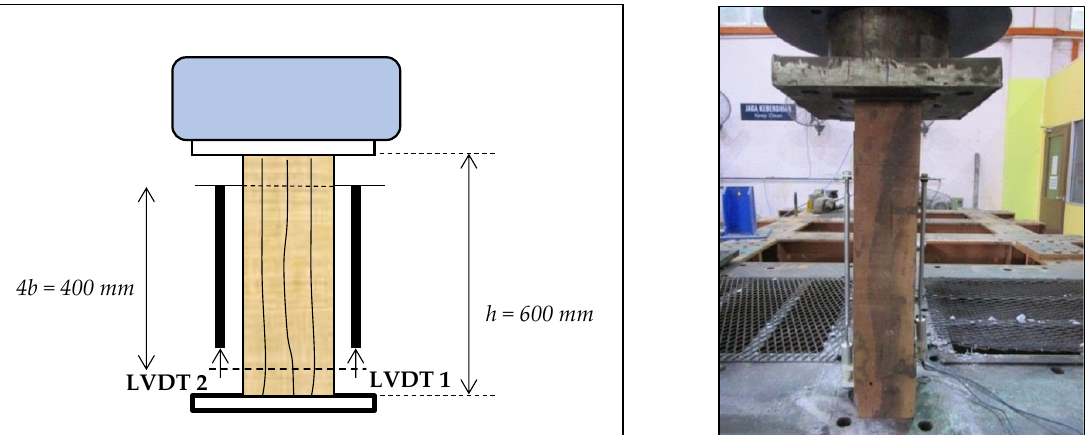
Figure 2. Test setup for determining compressive strength properties parallel to the grain.